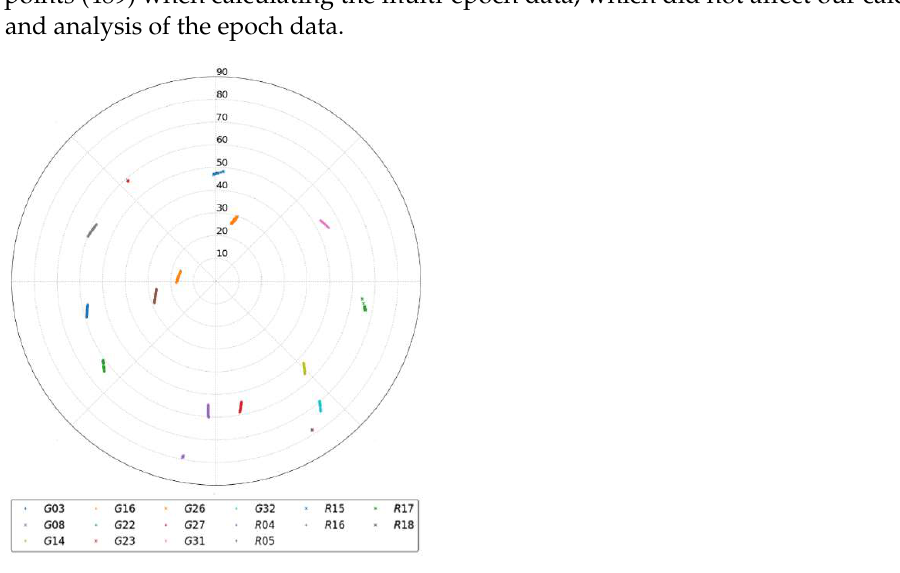
Figure 4. Satellite distribution in the sky at a certain time when single-point positioning trees in the field using the Galaxy 6